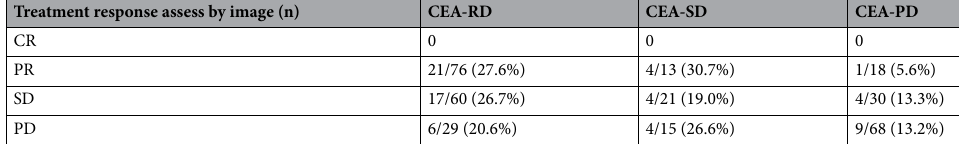
Treatment response assess by image